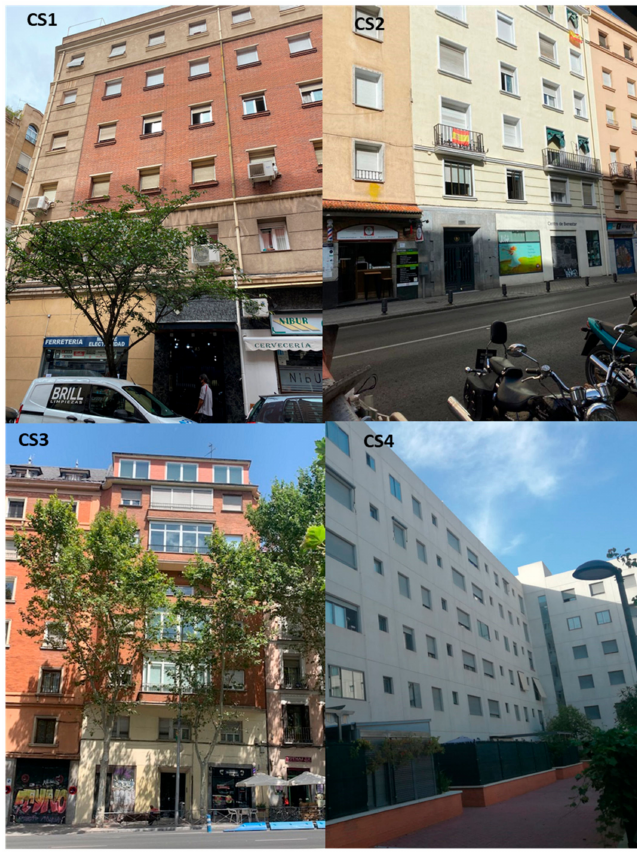
Figure 3. Case study